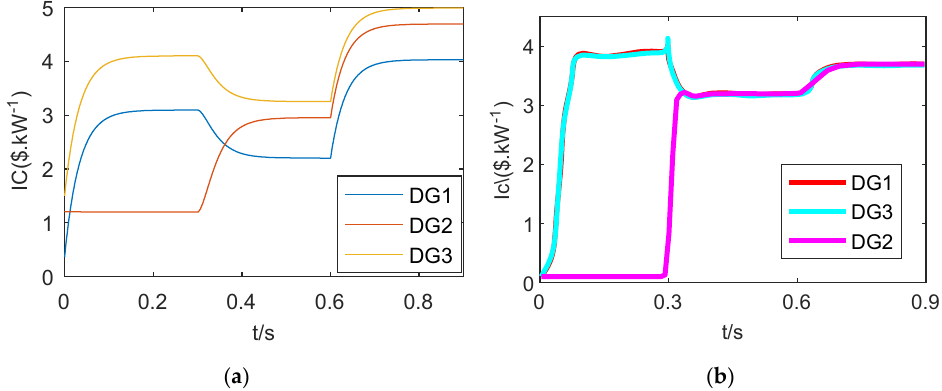
Figure 9. DC subnet cost micro increment. ( a ) Micro increment of each node cost of DC subnet under traditional droop control. ( b ) Cost micro increment of each node of DC subnet based on OPPRA. The voltage fluctuation diagram of each DC subnet node is shown in Figure 10.